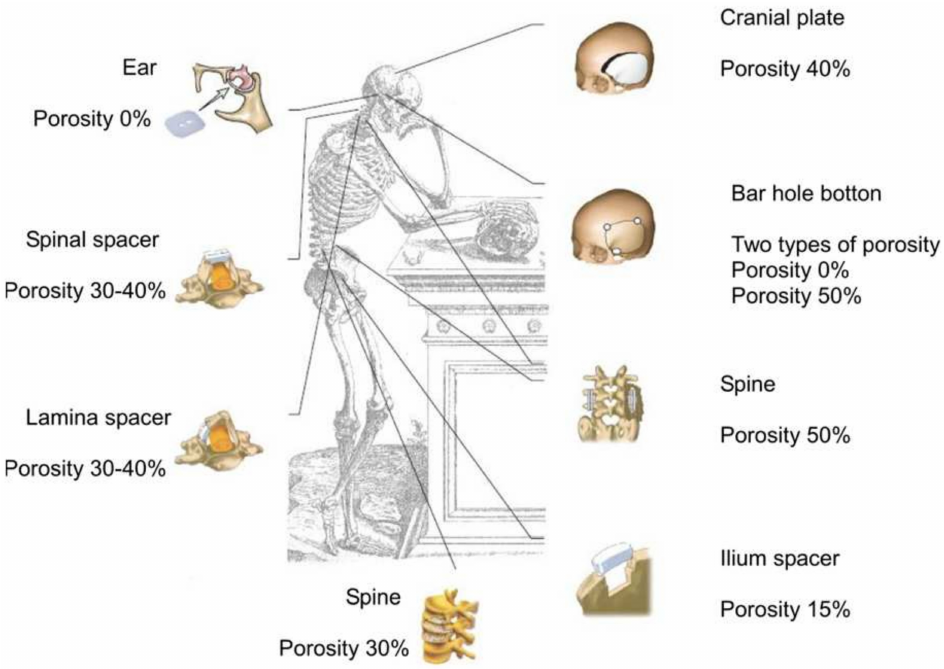
Figure 22. A schematic drawing presenting the potential usage of HA with various degrees of porosity. Reprinted from Ref. [518] with